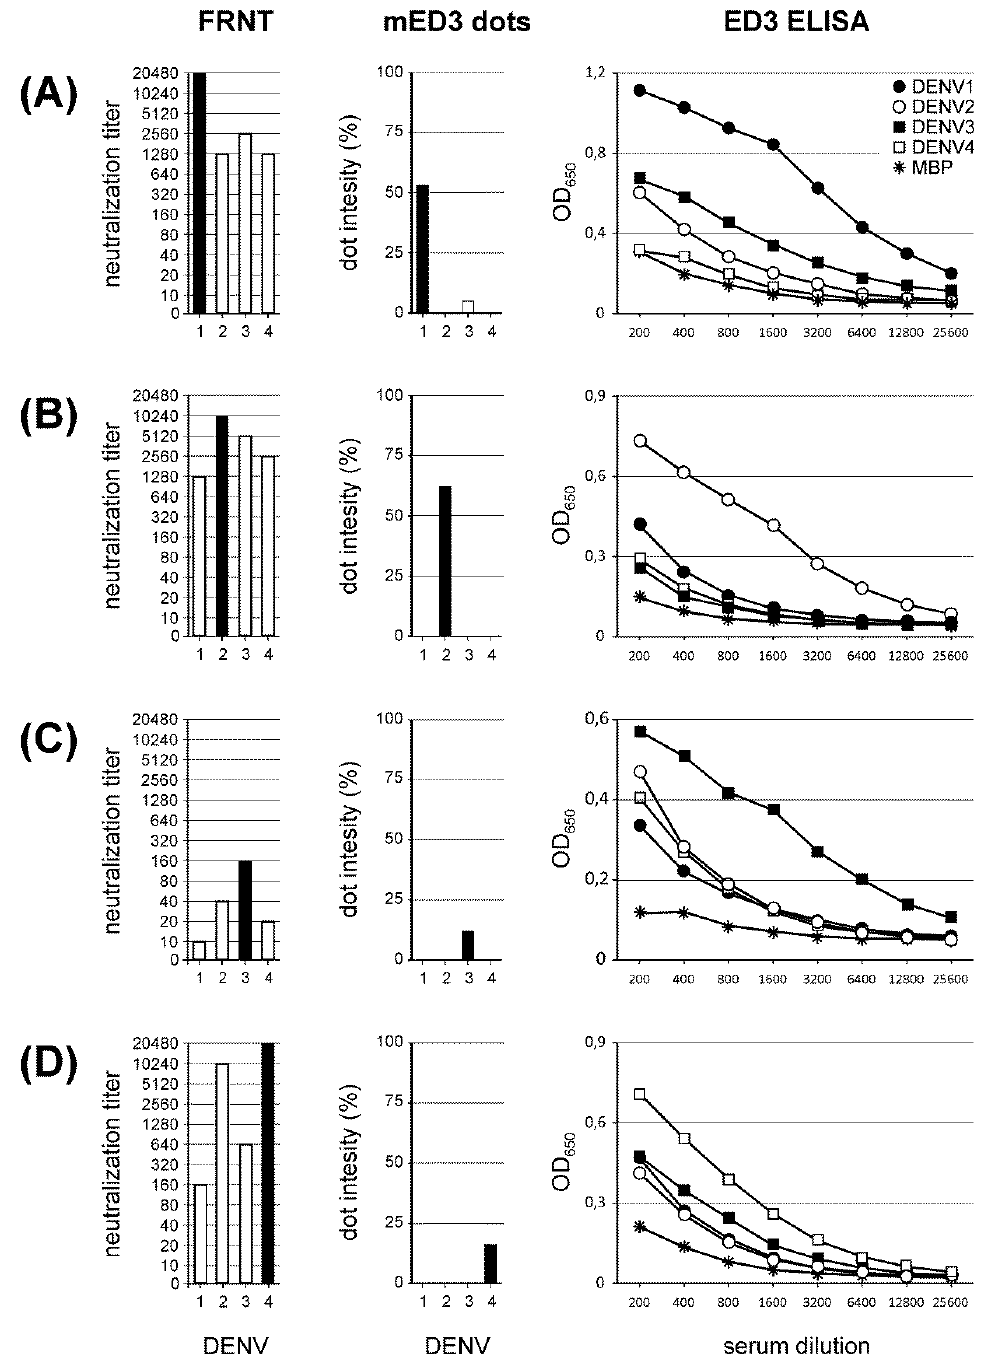
Figure 3. Comparison of FRNT, mED3 dot intensity and ED3 ELISA. Assay data are exemplarily shown for the detection of DENV-1-4 serotype-specific antibodies ( A – D , respectively). The antibody specificity determined by FRNT is indicated by the highest FRNT 90 titer (black bars, x-axis; numbers indicate DENV-1-4). The specificity detected by mED3 is indicated as the highest intensity obtained, based on data observed by the ED3 dot assay (black bars, x-axis; numbers indicate DENV-1-4). Serotype-specific antibody responses analyzed by ED3 ELISA are indicated by the highest OD 650 value through all serum dilutions. ED3 antigens for DENV-1, black circles; DENV-2, white circles; DENV-3, black squares; DENV-4, white squares and MBP as a control, asterisks.